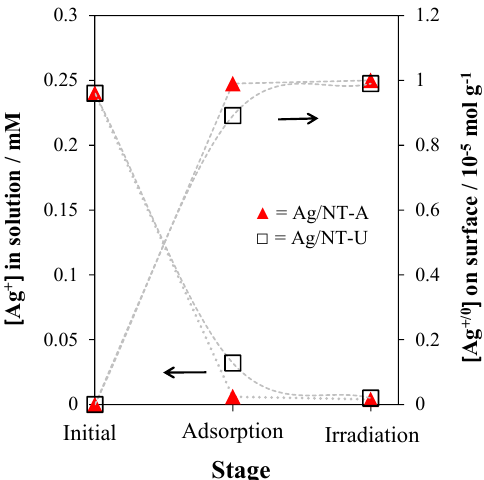
Figure 3. Change of Ag + concentration in the solution phase (left y axis) and Ag + (by adsorption) or Ag 0 (by photo-reduction) concentrations on the catalysts (right y axis) during the adsorption and photo-deposition processes in the preparation of Ag / NT-A and Ag / NT-U catalysts (with 10 − 5 mol g − 1 Ag concentration).